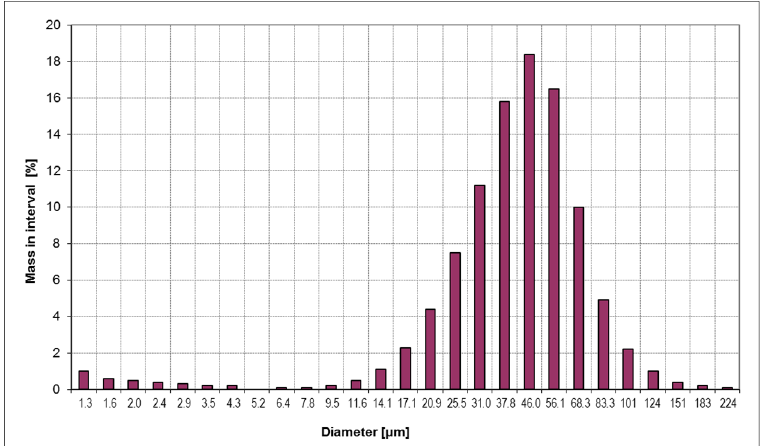
Figure 6. Particle size distribution of the core-shell filler.